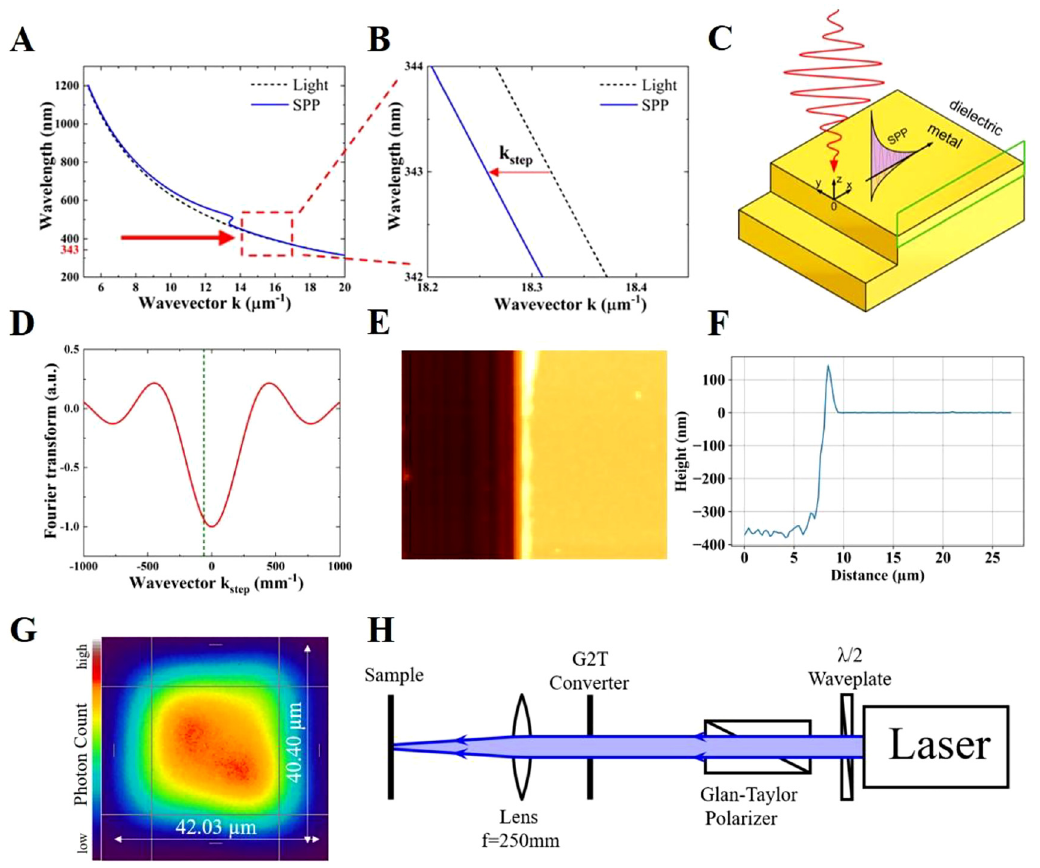
Figure 1: Schematic representation of the system and the experimental setup. (A)LightandSPPdispersion(realpart)relations.(B)LightandSPPmomentummismatch: k STEP = k ′ SPP − k las ≈− 62mm − 1 atthelaserwavelength 343 nm usedinour experiments, k STEP is a step edge wave vector, k ′ SPP is the real part of the wave vector of the SPP inthe x -direction, k las is the wave vector of light. (C) The schematic step edge irradiation geometry with SPP excitation. The green frame shows the simulation region for the MD-TTM. (D) Fouriertransformof thestepedge. Dashedlineindicate k STEP ,whichshouldbeprovidedtolight with343nmwavelength by the step edge to couple SPP. (E) Atomic force microscope recording of a trench (step edge) on the gold sample. (F) The average height pro fi le measured by the atomic force microscope. (G) The beam pro fi le in the surface plane. (H) The experimental